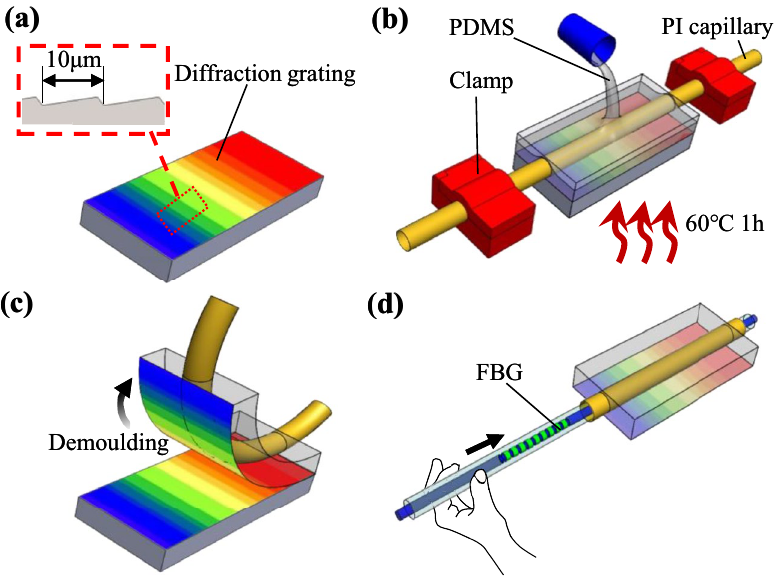
Figure 3. Steps followed to fabricate the self-adhesive PDMS-packaged FBG sensor. ( a ) Use of diffraction grating to imprint a wedge-shaped microarray structure with 10 μm period and 0.343 μm depth. ( b ) PDMS preparation in a mould placed inside a temperature chamber, with a polyamide capillary clamped at both ends. ( c ) Fabricated PDMS packaging is removed from the mould. ( d ) Optical fibre is passed through the polyamide capillary so as the FBG sensor remains loosed in the middle of the